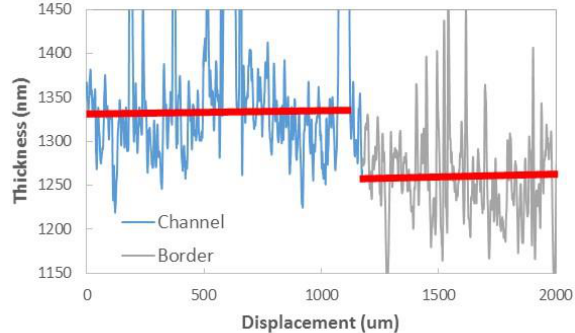
Figure 5. Profilometer measurement of the sensing channel and its border, in a NFs layer in which DIW has flowed for 6 h. Median values of each region are presented with solid lines.